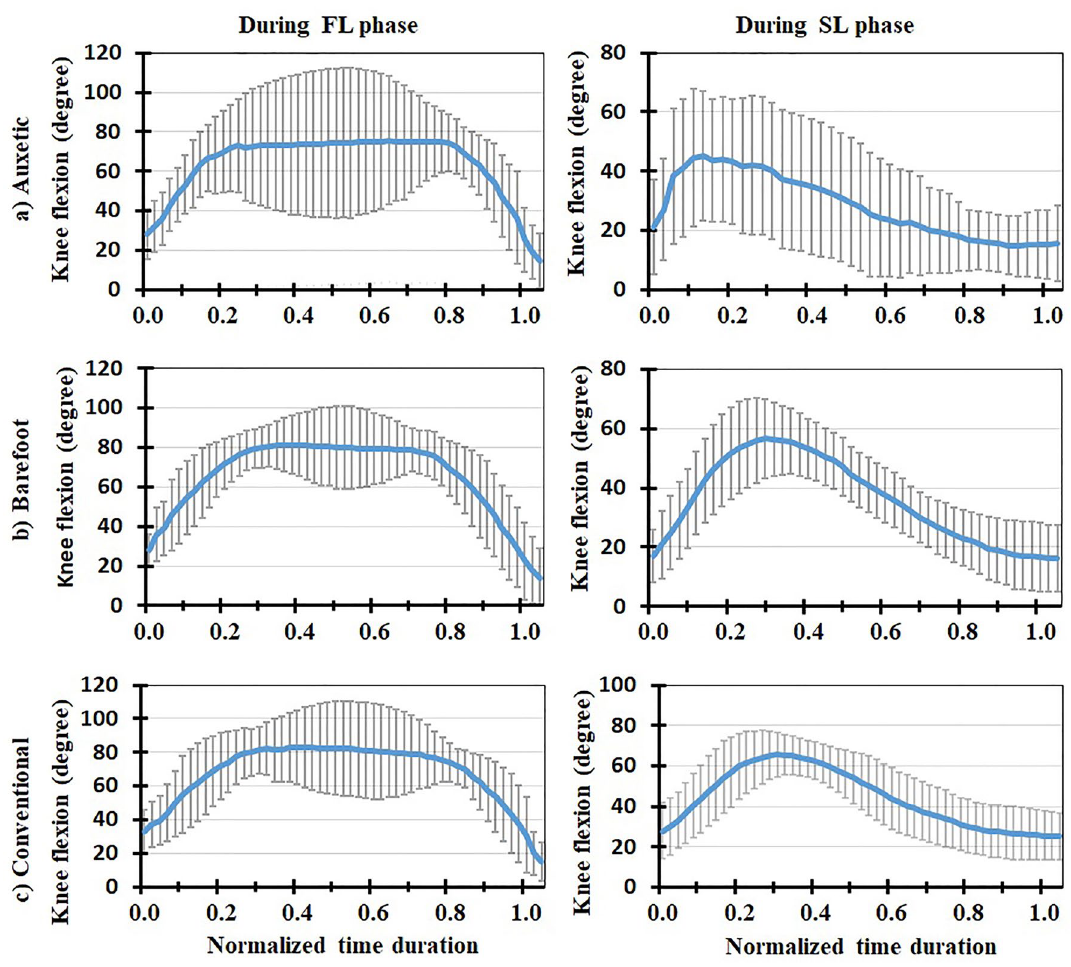
Figure 7. Mean knee flexion (degree) for all the participants (+ / − one standard deviation) in three footwear conditions: ( a ) auxetic shoe, ( b ) barefoot, and ( c ) conventional shoe. Left and right plots indicate variations during FL and SL phases of DVJ,